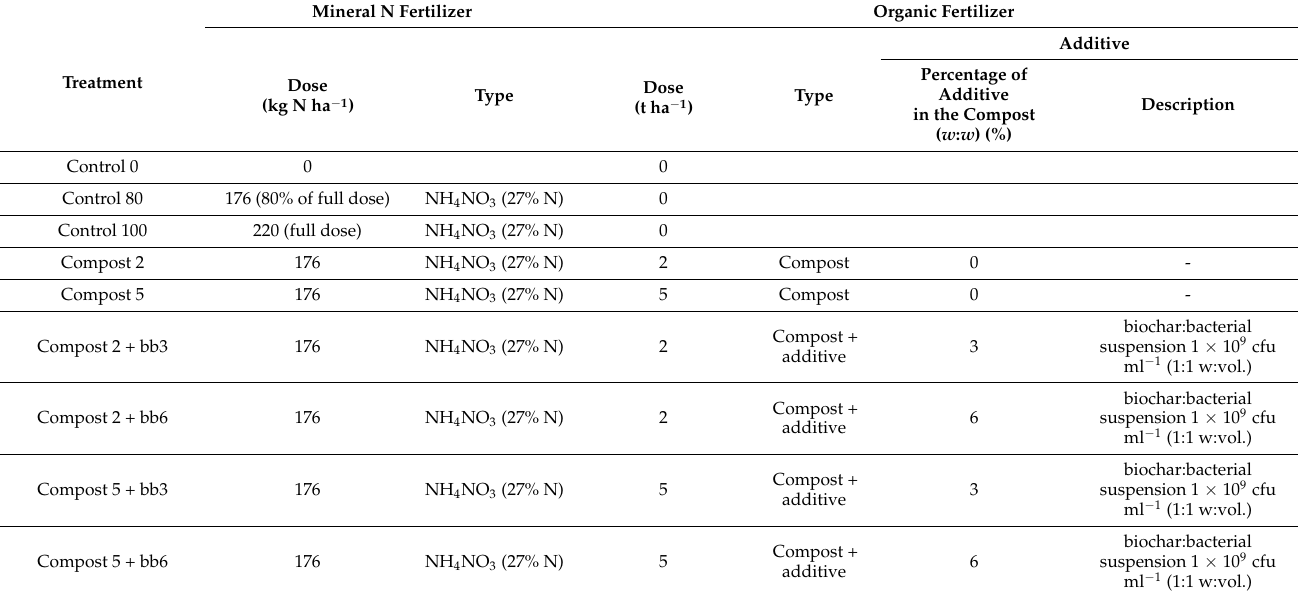
Table 1. Controls and treatments carried out in the field trial for melon and pepper